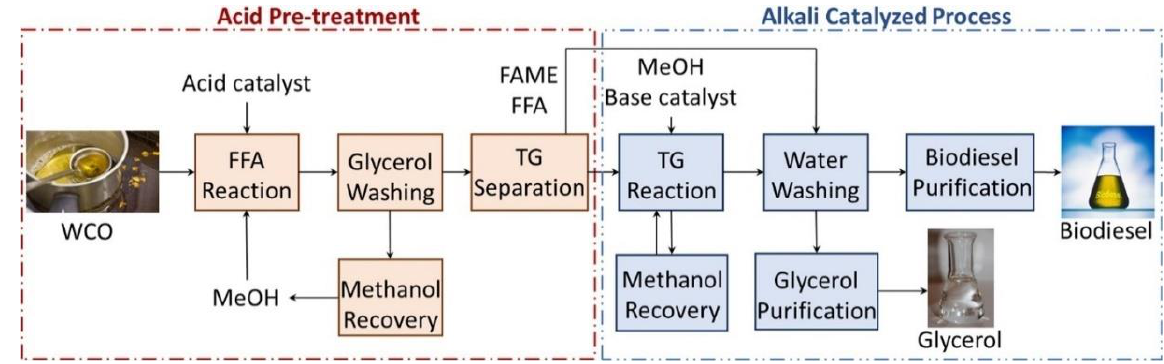
Figure 6. The direct transesterification of waste cooking oil (WCO) using acidic and alkaline cata- lysts [155]. WCO: waste cooking oil; FFA: free fatty acid; MeOH: methanol; TG: triglycerides; FAME: fatty acid methyl esters.